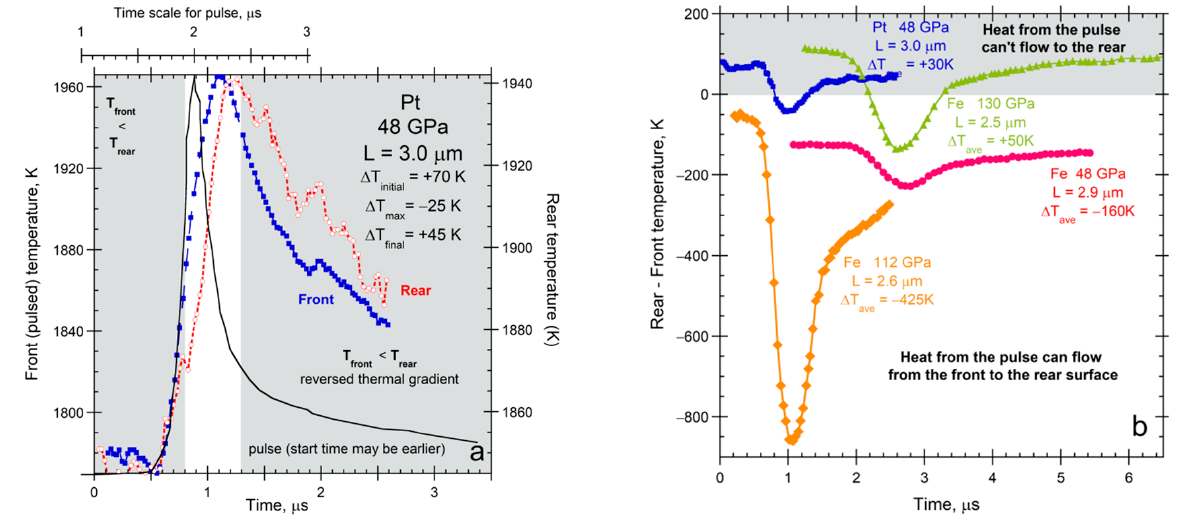
Figure 13. Temperatures calculated in two-laser DAC experiments: ( a ) Example from [81], digitized and rescaled. Squares represent the front surface which absorbs the laser pulse and circles represent the rear. Conditions and T differences are listed. Y-axes limits were chosen so each T - t profile fills the graph. Platinum experiments [81] began with the rear surface being hotter (grey rectangle), which prohibits the diffusion of heat from the front to the rear but permits the travel of the laser beam. Thin black curve = laser pulse profile [81]. Since the relationship of data collection to the pulse was not specified, the laser profile was placed where the front surface began warming. Part ( a ) was modified after Figure 3d,f of McWilliams et al. [81], with permissions from Elsevier. ( b ) Temperature differences across the ~3 µ m foil of Pt compared to those in experiments on iron [82], obtained from digitizing and subtracting temperature curves in [81,82]. Grey rectangle shows times where the rear surface is undesirably hotter than the front. Average T differences are